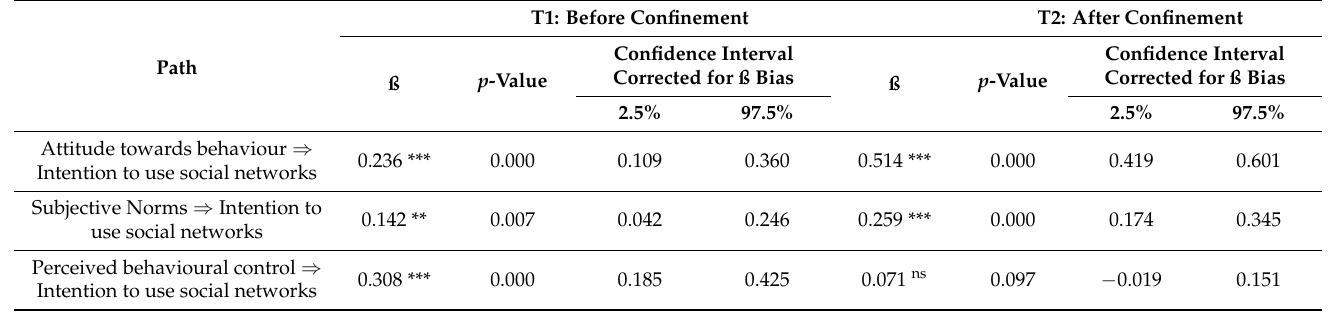
Table 2. PLS-SEM analysis of the factors in the TPB model before and after confinement in elderly adults from